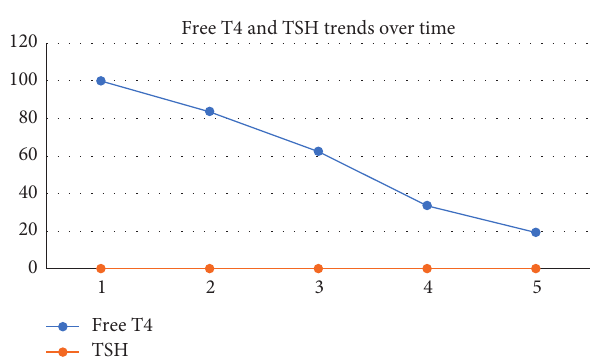
Figure 2: Trends of free T4 and TSH in the first 6 days of hospitalisation.